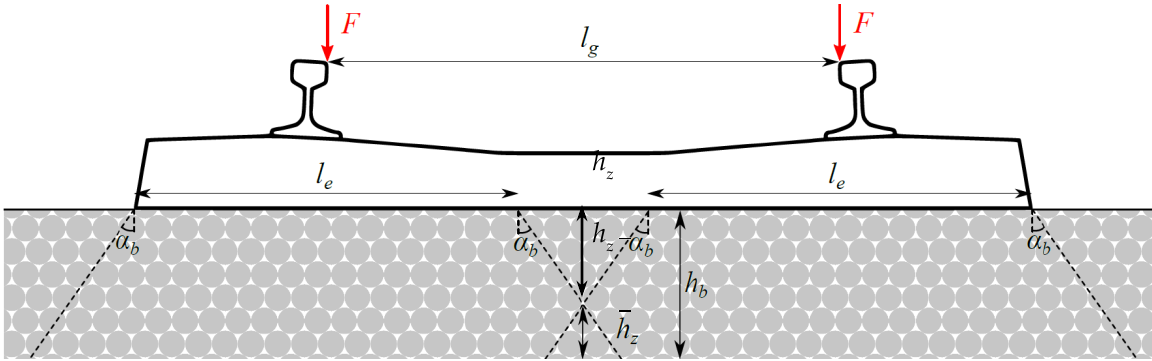
Figure 7. Static vertical stress in the 3D FE model of the railway track. Blue: maximum negative stress in the ballast; red: 0% to 10% of the maximum negative stress; grey: values out of range; 0.6m h = b